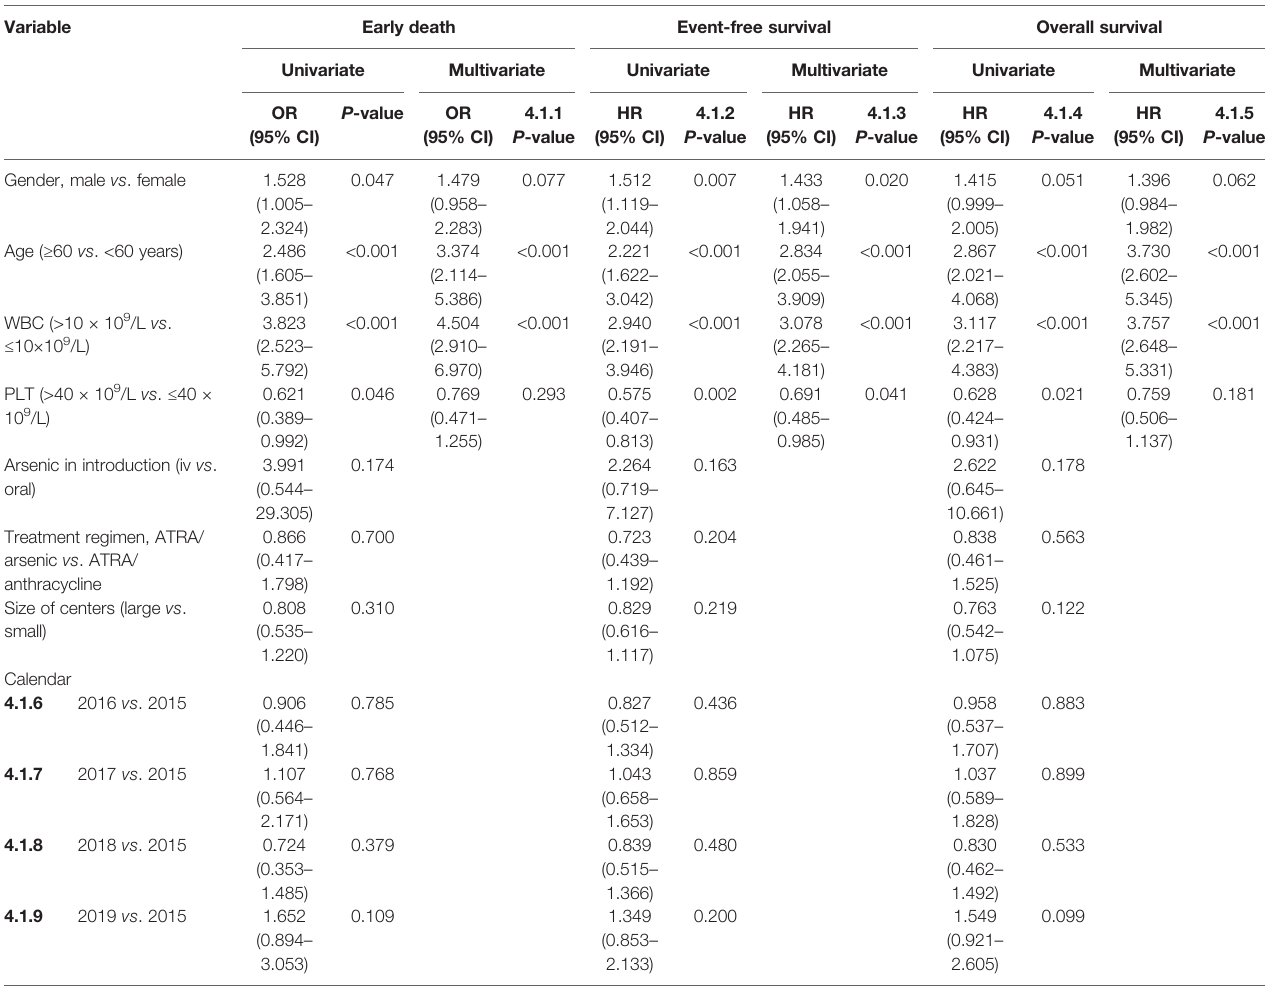
TABLE 2 | Univariate and multivariate analyses of early death, event-free survival, and overall survival. Variable Early death Event-free survival Overall survival Univariate Multivariate Univariate